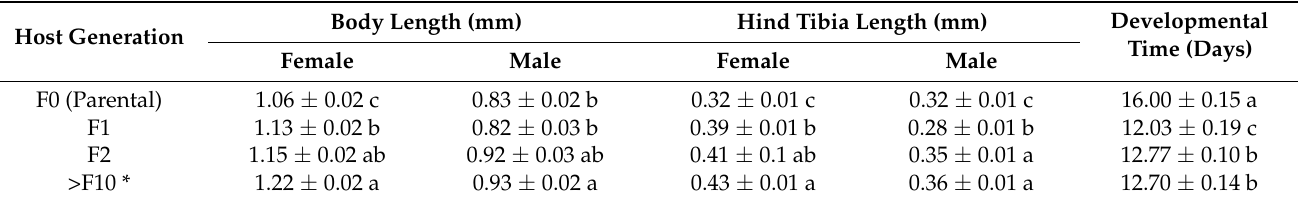
Table 2. Body size and developmental plasticity of A. asychis transferred from S. avenae to A. pisum